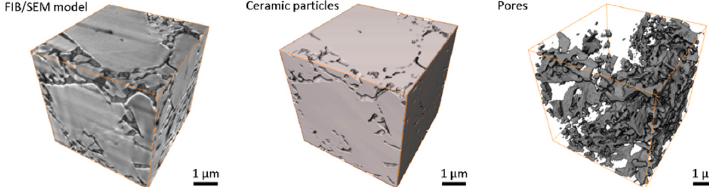
Figure 8. FIB/SEM-based 3D images of Al ₂ O ₃ brownbody ceramic sample, manufactured and processed with stereolithography-based additive technology; there are shown the original FIB/SEM greyscale 3D image and the results of image segmentation: ceramic particles and pores.